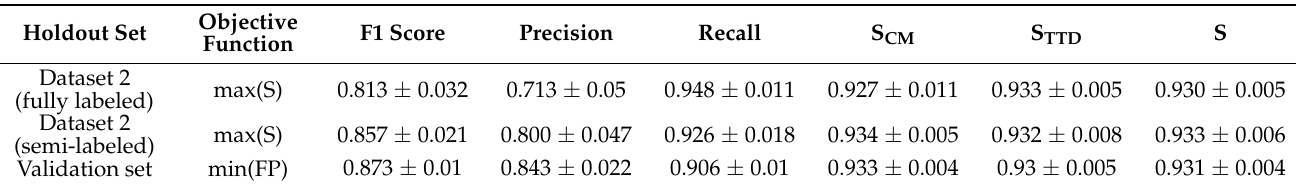
Table 1. How different data availability scenarios (regarding the holdout set) affect the algorithm’s performance in the test dataset.